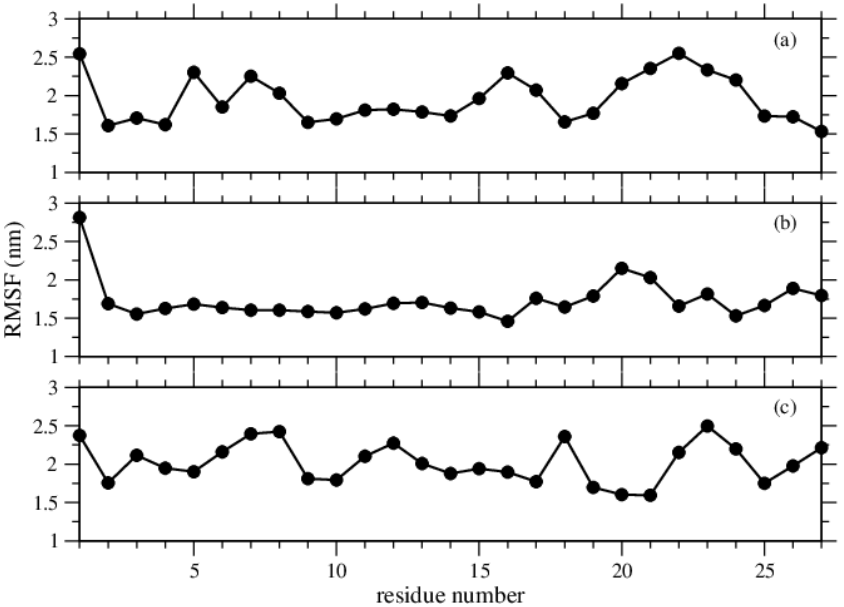
Figure 3. RMSF per residue of the amino acids, ( a ) Phe, ( b ) Tyr, and ( c ) Trp molecules.